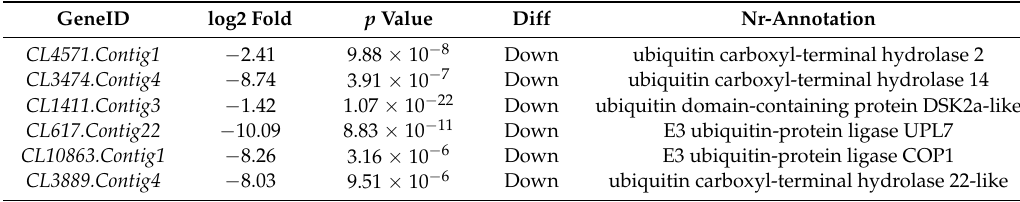
Figure 5. Relative expression of genes related to heat shock proteins (HSPs), heat stress transcription factor (HSFs), and cytochrome P450. Data are presented as the mean ± standard deviation ( n = 9). * 0.01 ≤ p ≤ 0.05, ** p ≤ 0.01, Student’s t test. Table 3. Genes related to ubiquitin-protein ligase.